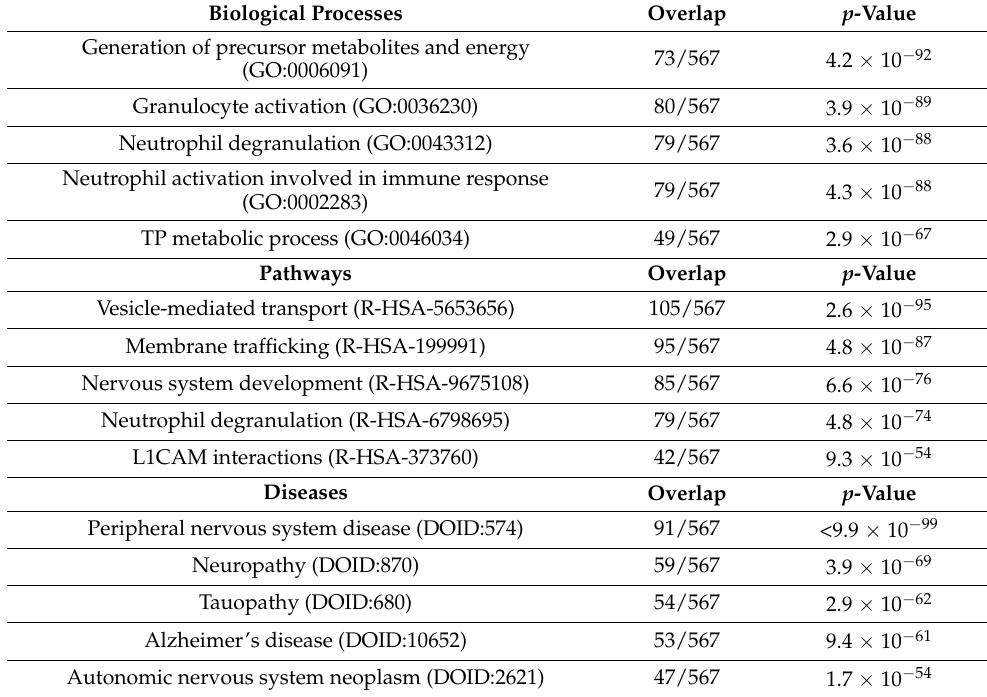
Table 3. Annotations of myelin protein involved in PPI